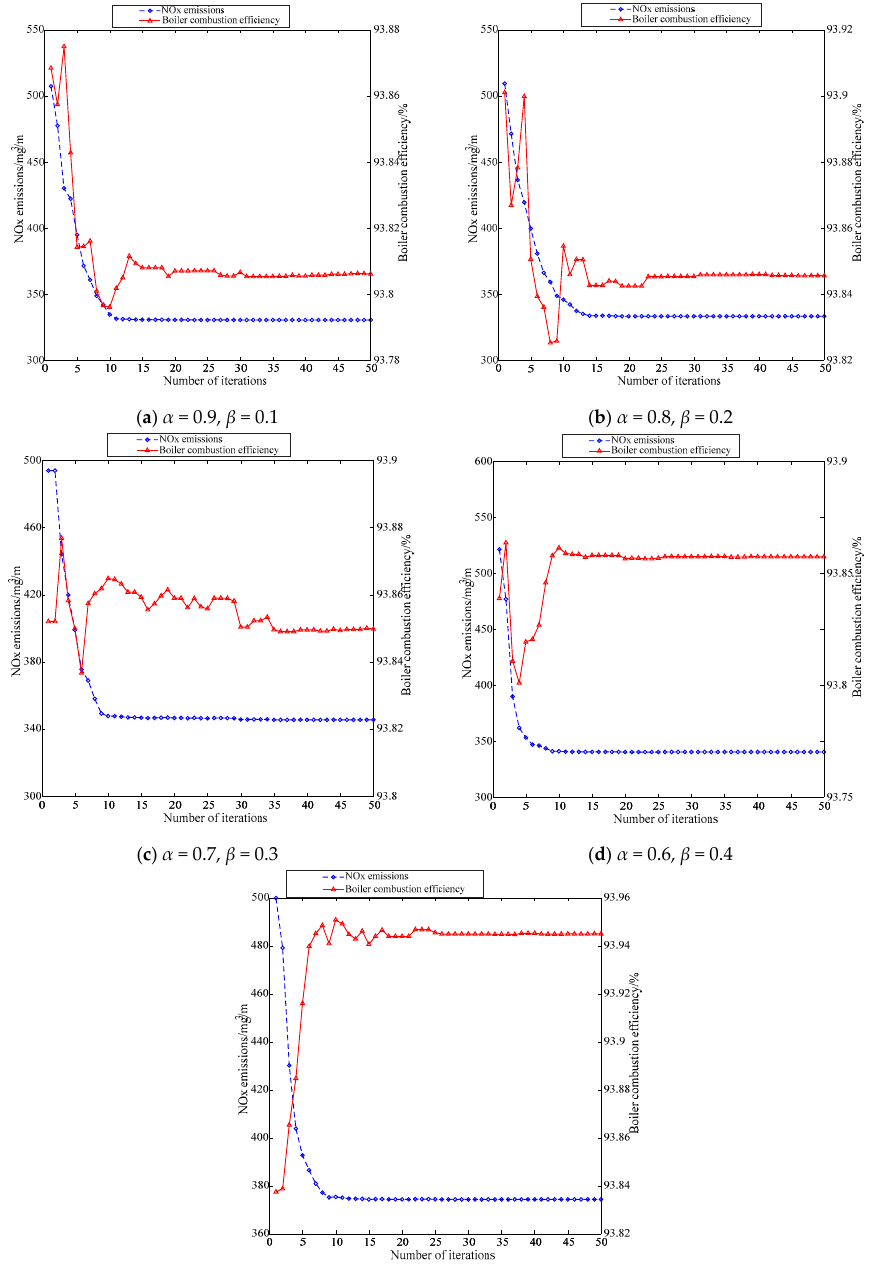
Figure 11. Optimization results of NO x emissions and boiler combustion efficiency under different weight ratio.